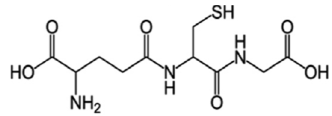
Figure 6. Chemical structure of glutathione.